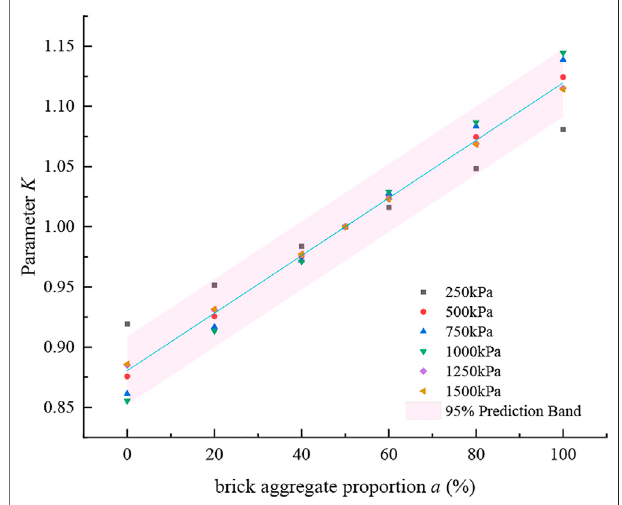
FIGURE 9 | Parameter K vs aggregate proportion.